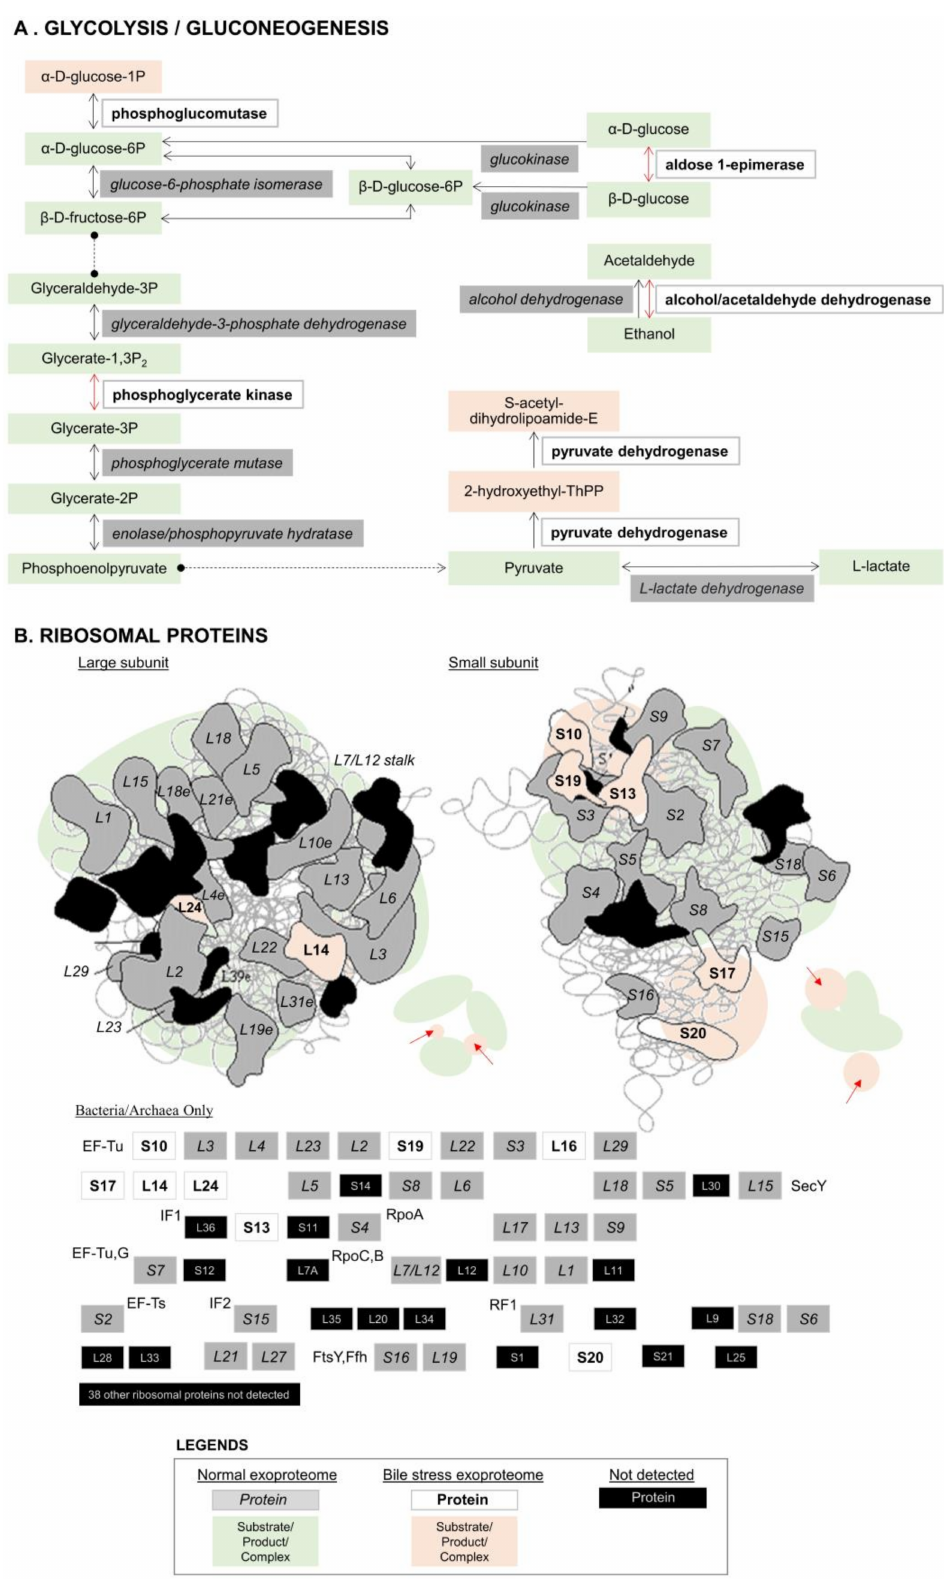
Figure 2. The top functional modules and pathways detected through KEGG-based analysis of the Lactobacillus mucosae LM1 exoproteome. The presence of specific proteins under normal conditions and bile stress (0.10% and 0.30% bile) mainly influenced the glycolysis/gluconeogenesis pathway ( A ) and specific components of the large and small ribosomal subunits ( B